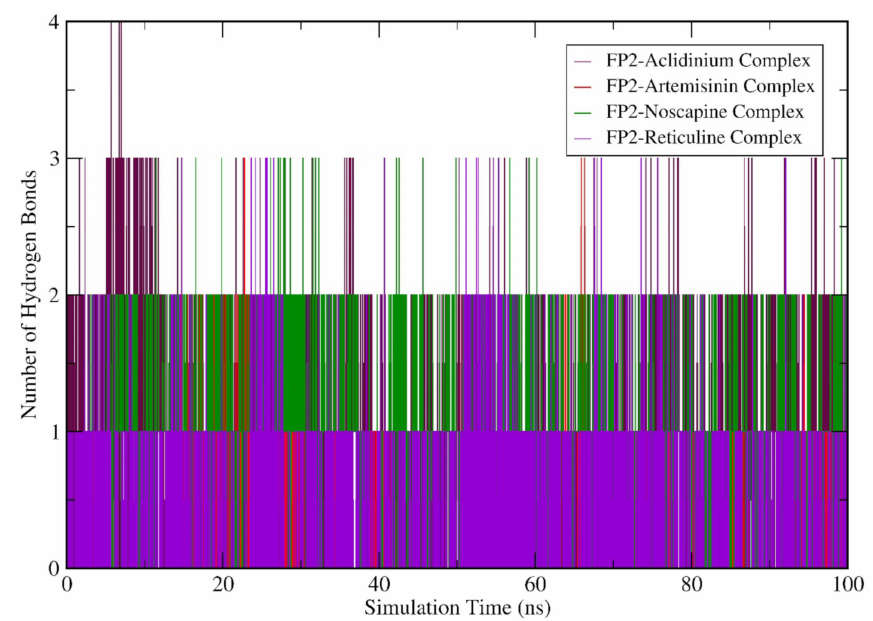
Figure 8. Molecular dynamics simulation (MDS) result analysis for FP-2-Artemisinin, FP-2 Noscapine, FP-2 Reticuline, and FP-2 Aclidinium complexes representing H-Bond (Hydrogen